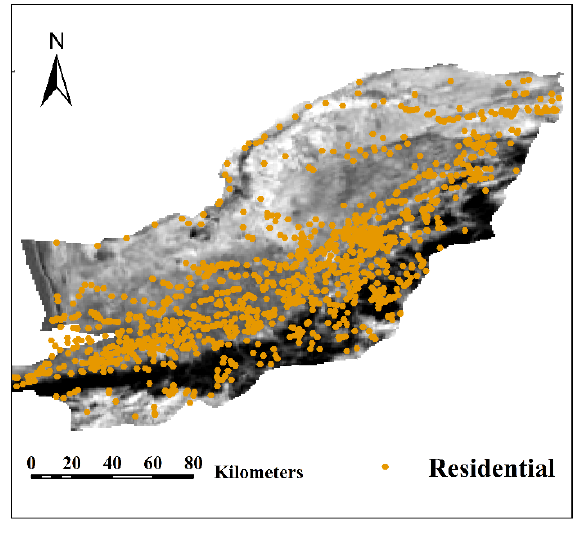
Figure 4 . Residential region